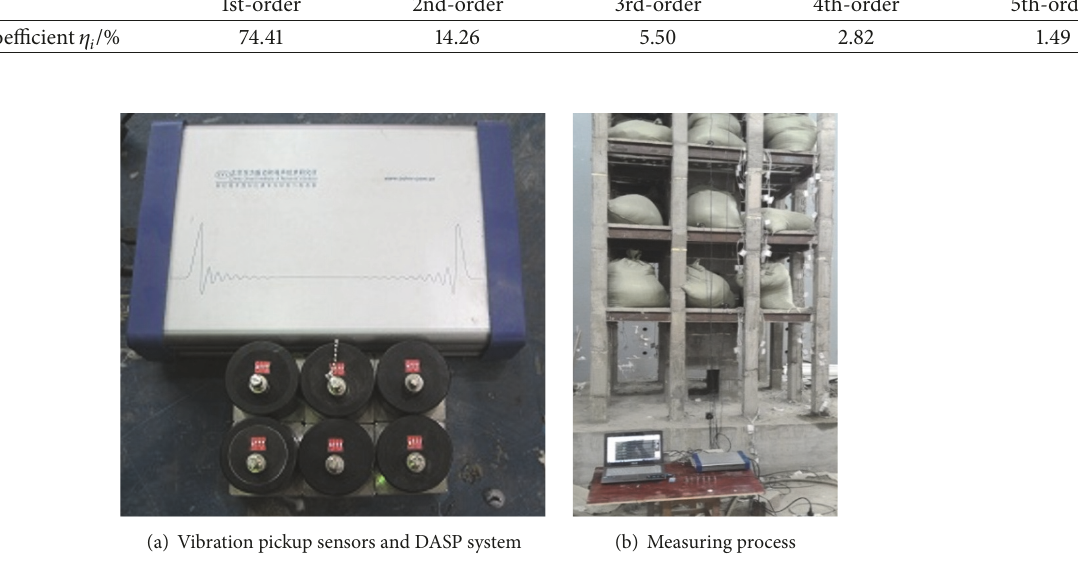
Figure 7: Measurement for dynamic characteristics.